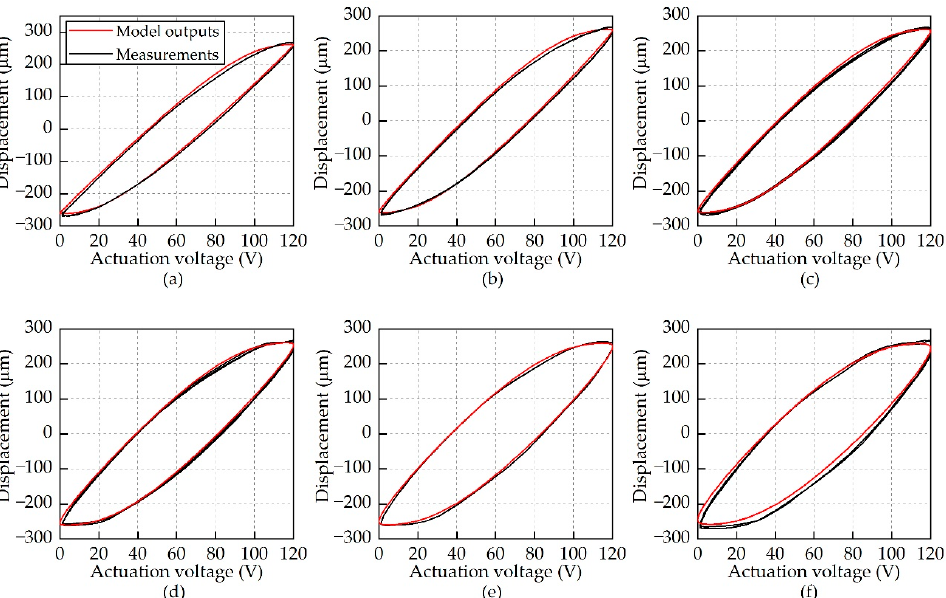
Figure 7. Comparison of the measured output strokes and the model outputs at different frequencies. ( a ) 10 Hz; ( b ) 20 Hz; ( c ) 30 Hz; ( d ) 40 Hz; ( e ) 50 Hz; and ( f ) 60 Hz.